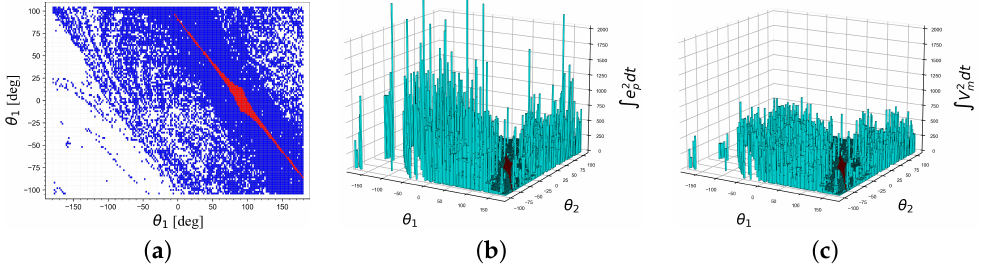
(cid:82) (cid:82) e 2 p dt , ( c ) V 2 m dt .